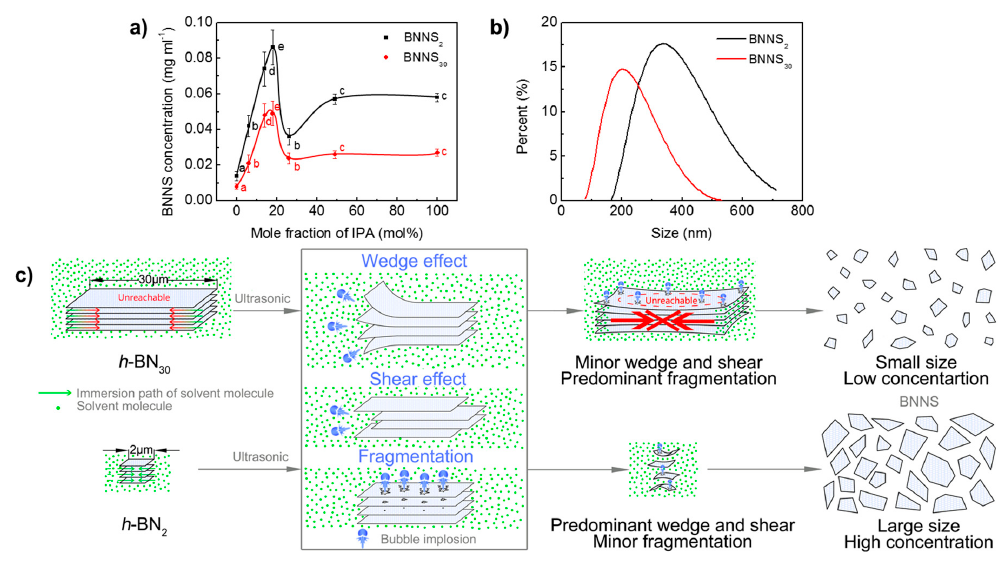
Figure 2. Effect of raw h -BN size on exfoliation. ( a ) Change of BNNS concentration with co-solvent formulations. ( b ) Size distribution of BNNSs. (production conditions: exfoliation time of 48 h, centrifugal speed of 3000 rpm, and 19 mol% IPA). ( c ) Schematic diagram of the effect of raw h -BN size on liquid exfoliation efficiency. Data presented as means ± SD. Α = 0.01, from small to large: a → e.